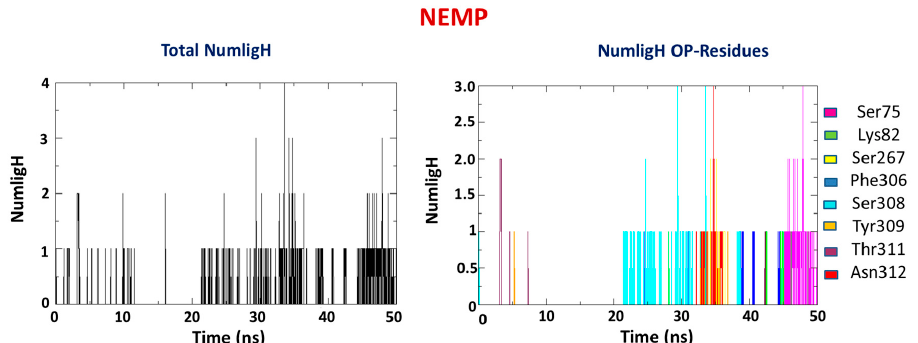
Figure 9. H-bond prevalence for the system PTE/NEMP.